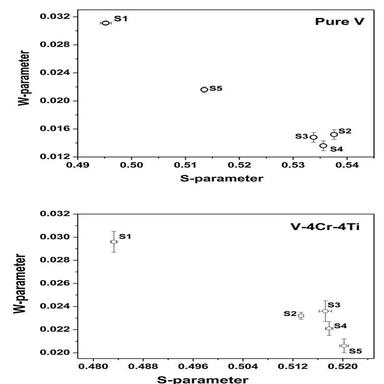
The S-W correlation plots of as received and ion irradiated Pure V and V-4Cr-4Ti alloy samples. S1-5 represent the Unirradiated sample and samples with dose of 5.5E14, 2.75E15, 1.1E16 and 2.75E16 Ar9+/cm2 respectively.